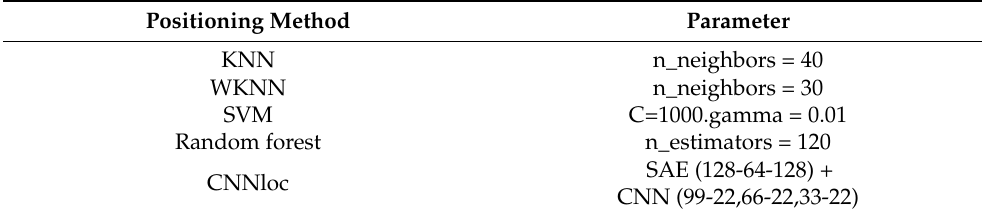
Figure 7. Positioning error with different methods on the Alcala Tutorial 2017 dataset. Table 7. The algorithms and their